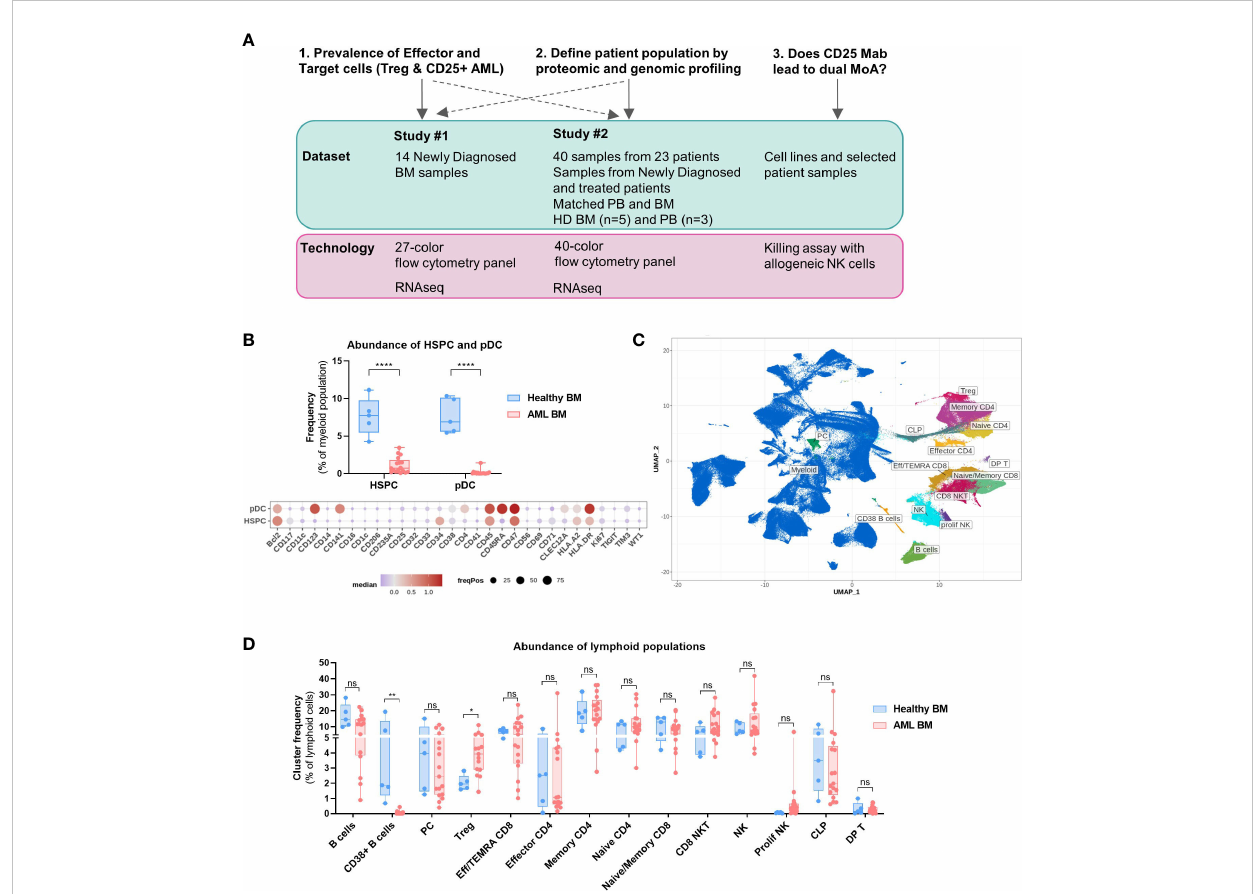
FIGURE 1 Bone marrow composition differs between healthy donors and AML patients. (A) Overview of the study. Shown are the key questions with associated datasets and technologies used. (B – D) Data obtained with BM samples in Study #2. (B) Top: Abundance of pDC and HSPC in the bone marrow of healthy donors (n=5) and AML patients (n=17). Multiple t tests, Holm-Sidak correction for multiple comparisons. Bottom: Dot plot depicting the expression of 30 selected markers on HSPC and pDC identi fi ed in combined clustering of healthy and AML bone marrow samples. Color code indicates the median expression (logicle transformed MFI); point size indicates the fraction of cells positive for each marker. (C) Lymphoid clusters overlaid on UMAP embedding of all BM samples (healthy and AML). (D) Differential abundance of all lymphoid clusters between Healthy and AML BM as a proportion of lymphoid cells. Multiple t tests, not corrected for multiple comparisons. BM, Bone marrow; PB, Peripheral blood; HD, Healthy donor; Treg, Regulatory T cell; MoA, Mode of action; HSPC, Hematopoietic Stem and Progenitor cell; pDC, Plasmacytoid dendritic cell. Signi fi cance levels are indicated as follows: ns or not indicated, not signi fi cant, P > 0.05; *P ≤ 0.05; **P ≤ 0.01; ***P ≤ 0.001; ****P ≤